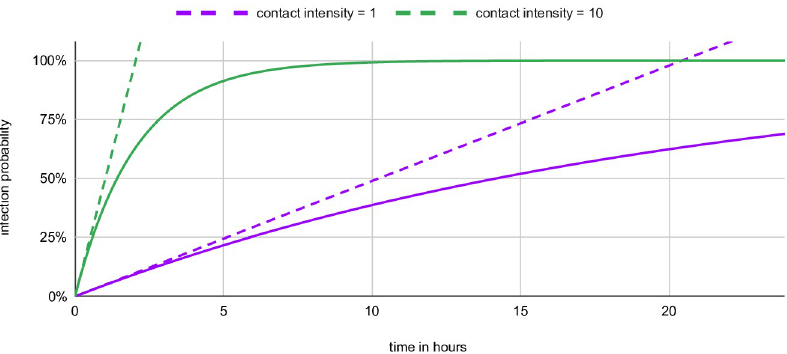
Fig 2. How duration (in hours) translates into the infection probability for two different contact intensities. The linear approximation of Eq (2) is given for either curve by a dashed line.